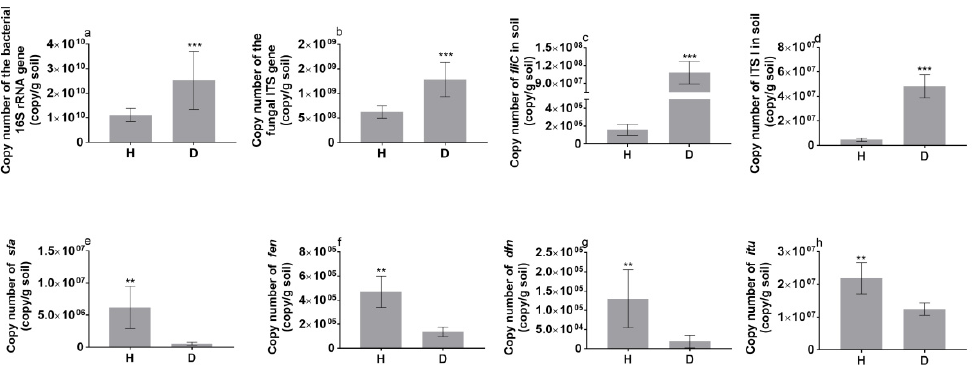
Figure 3. Copy number of functional genes in the rhizospheres of healthy (H) and bacterial wilt-diseased (D) tomato plants. ( a ) 16S rRNA, ( b ) ITS, ( c ) fliC , ( d ) ITS I, ( e ) sfr , ( f ) fen , ( g ) dfn and ( h ) itu represent total bacteria, total fungi, R. solanacearum , F. solani , surfactin, fengycin, difficidin and iturin, respectively. Statistical significance was determined based on Student’s t-test. *** P < 0.001, ** P < 0.01, * P < 0.05.